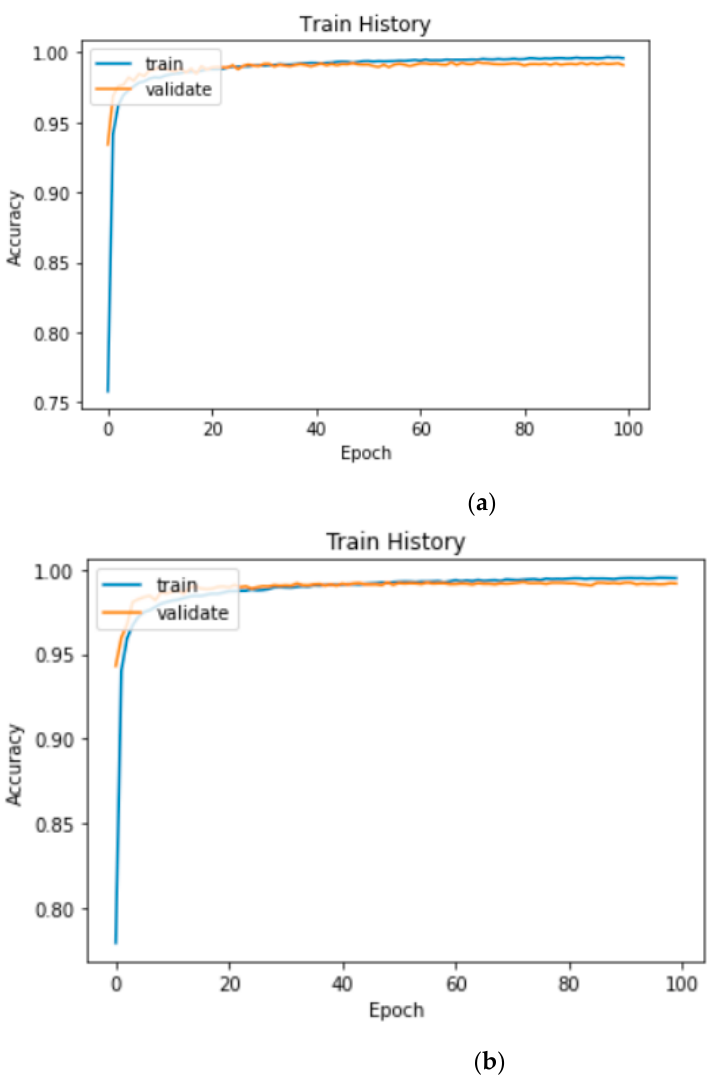
Figure 11. Recognition accuracy curve of the proposed two-channel CNN–BiLSTM model: ( a ) run on the CPU and ( b ) run on the GPU.